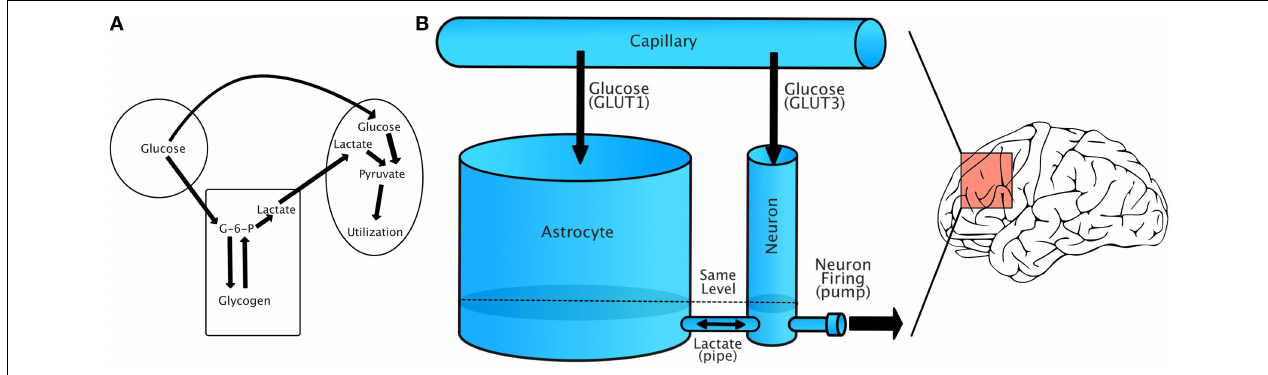
FIGURE 1 | Energy flow during increased demand. (A) Simplified account of capillary/glycogen/astrocyte relationship, modified from Brown (2004). (B) A schematic of our model, in which energy is treated as a single fluid flowing between compartments.